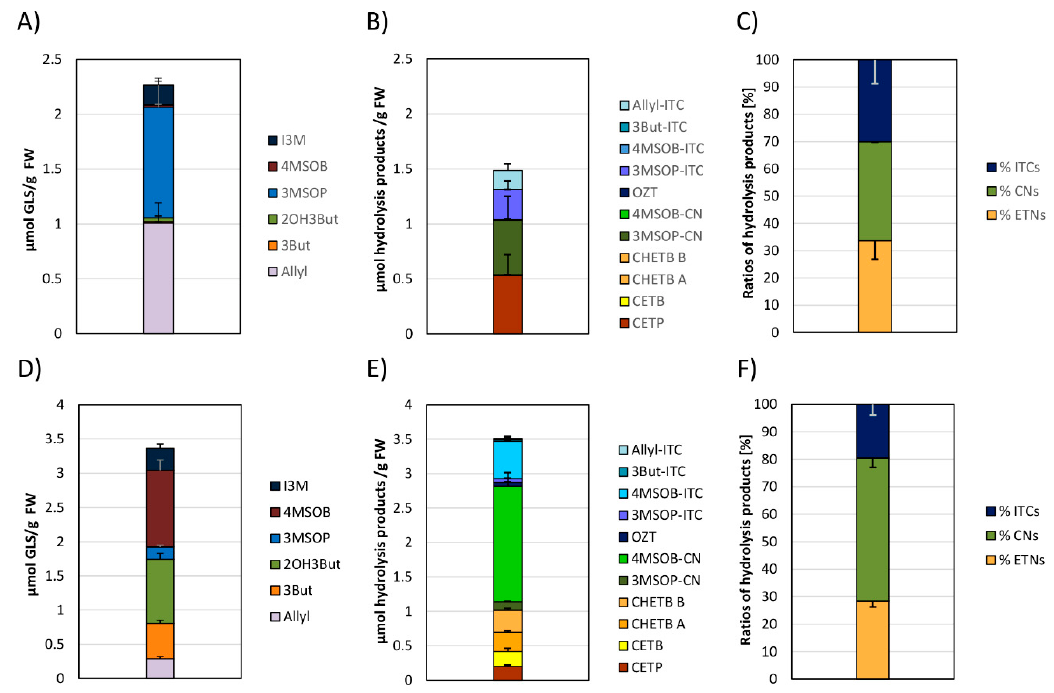
Figure 5. Glucosinolate (GLS) ( A , D ) and their absolute ( B , E ) and relative ( C , F ) hydrolysis product formation in white ( A – C ) and red cabbages ( D – F ) harvested freshly from the field. Each color in the bar of the given bar chart represents the mean plus standard deviation (SD) of the GLS ( A , D ), their respective hydrolysis products ( B , E ), or the ratio of relative isothiocyanates (ITCs), nitriles (CNs), and epithionitriles (ETNs) ( C , F ) from three cabbage heads freshly harvested from the field ( n = 3). Abbreviations: FW: Fresh weight; abbreviations of compounds are listed in Table 3.